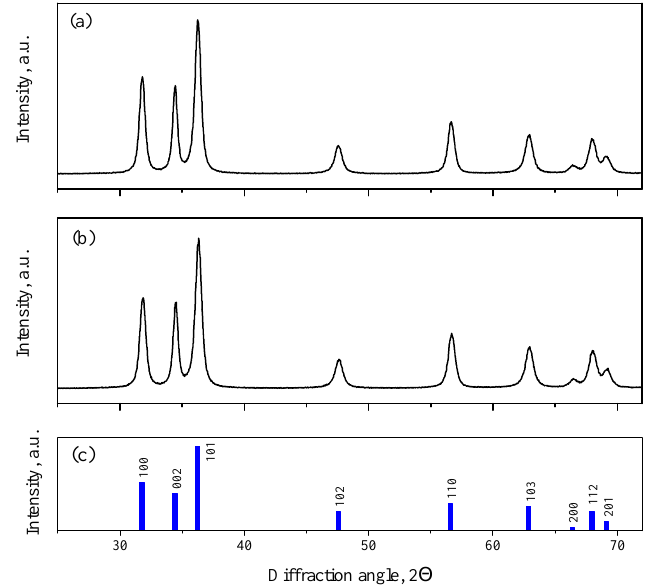
Figure 4. XRD patterns of ZnO-300 ( a ) and ZnO-V O ( b ) powder samples; ( c ) bar diffractogram of wurtzite ZnO (ICDD # 98-002-9272).